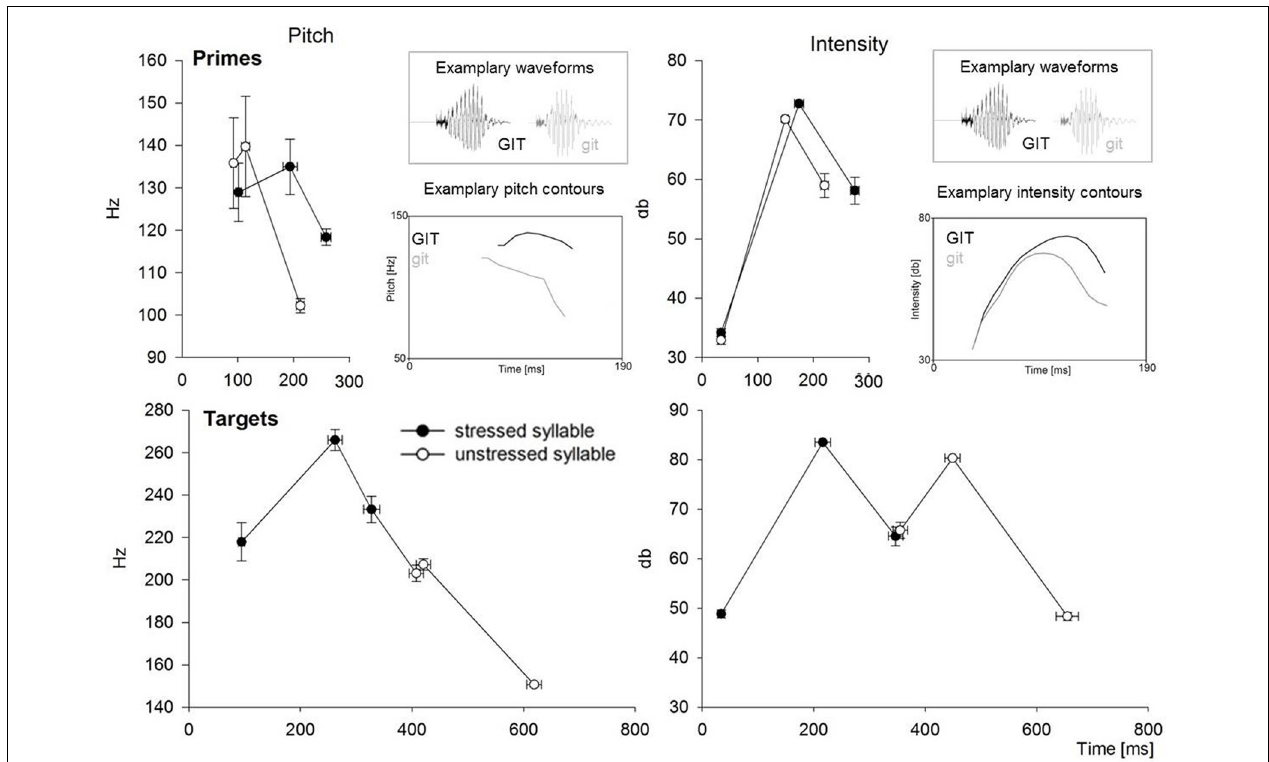
FIGURE 1 | The figure illustrates the pitch and intensity for the monosyllabic stressed and unstressed primes (above) and the disyllabic initially stressed target words (below) that were presented in the experiment. Simplified pitch and intensity contours are sketched by the mean first value, the mean maximum value and the mean last value for the monosyllabic primes, as well as for each syllable of the target words. The averaged values are given at the averaged time point they were identified in the signals for stressed and unstressed syllables respectively. Pitch and intensity values were obtained by considering the